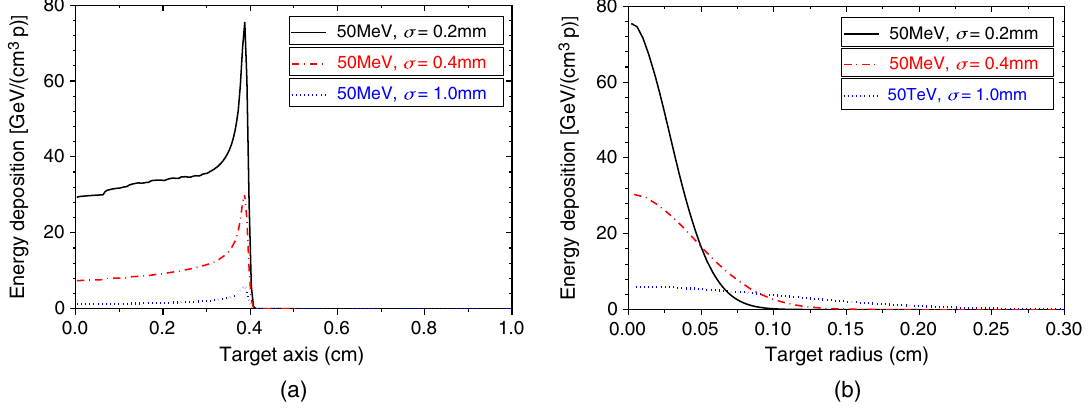
FIG. 3. Energy deposition per 50 MeV proton in a cylindrical copper target for three different beam sizes (a) in the longitudinal direction at r ¼ 0 and (b) in the radial direction at L ¼ 0 . 39 cm (position of the Bragg peaks). The three beam sizes are 0.2, 0.4, and 1.0